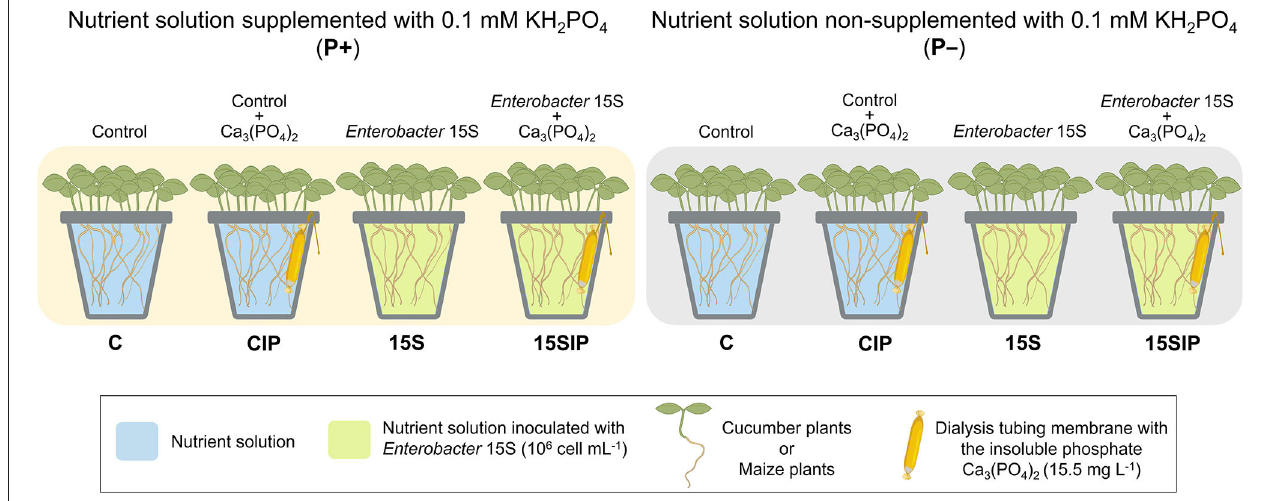
FIGURE 1 | The experimental design of the present study. Seedlings of cucumber or maize were grown on nutrient solutions (NSs) supplemented (P + ) or non-supplemented (P–) with 0.1 of mM KH 2 PO 4 . The bacterial biostimulant with Enterobacter 15S was used to inoculate the hydroponic NS to a final concentration of 10 6 cell ml − 1 (15S) and the NS in pots containing the insoluble phosphate Ca 3 (PO 4 ) 2 (15SIP). Two uninoculated controls, with the insoluble phosphate Ca 3 (PO 4 ) 2 (CIP) or without it (C), were also evaluated (Refer text in detail). The dialysis membrane used was a MEMBRA-CEL MD34 14 × 100, MWCO: 14000, Pore size: 50Å (Viskase Companies Inc., Willowbrook, IL,